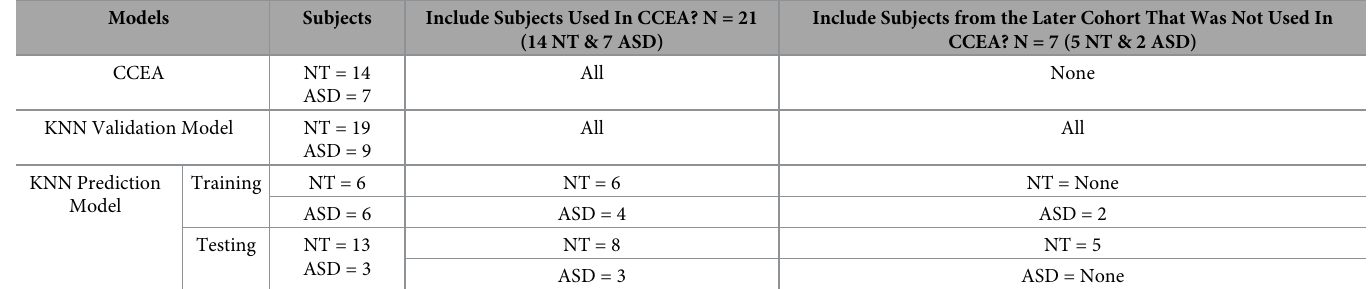
Table 2. Subject inclusion and distribution.